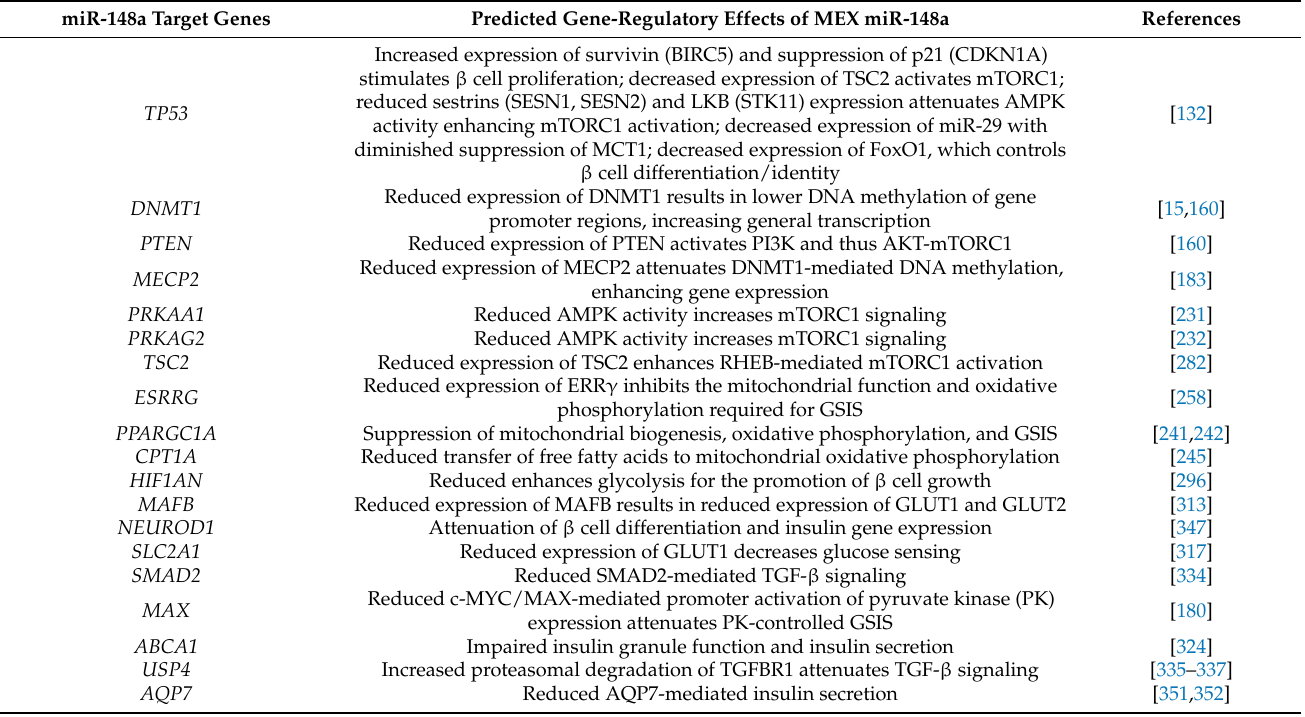
Table 1. Potential gene-regulatory effects of MEX miR-148a on postnatal β